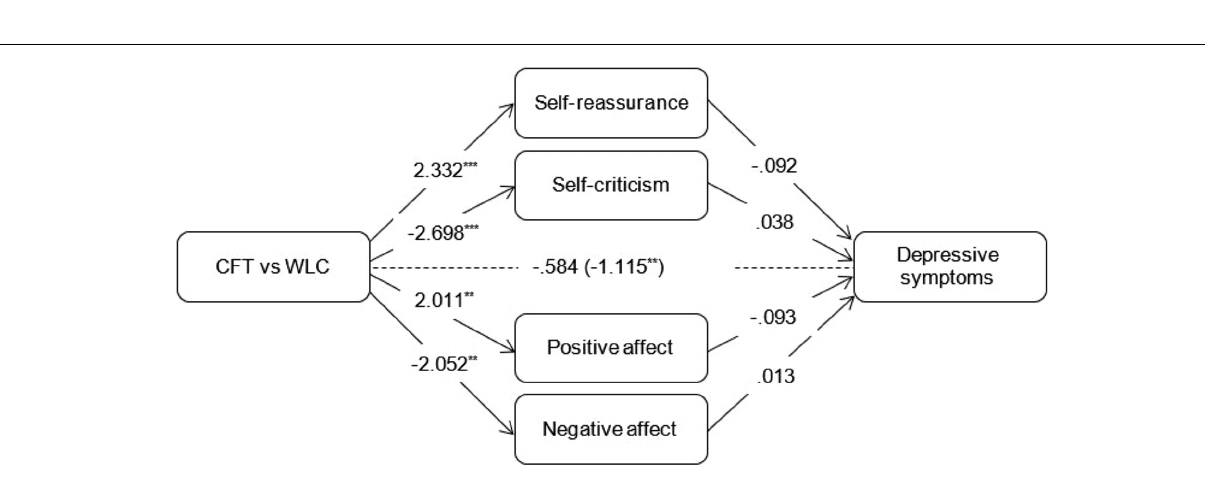
FIGURE 3 | Outcomes of multiple mediation models assessing indirect effects of mediators on changes in depressive symptoms compared to the waitlist control condition. Total effect (c-path) is given in parentheses. ∗∗ p < 0.01, ∗∗∗ p < 0.001.